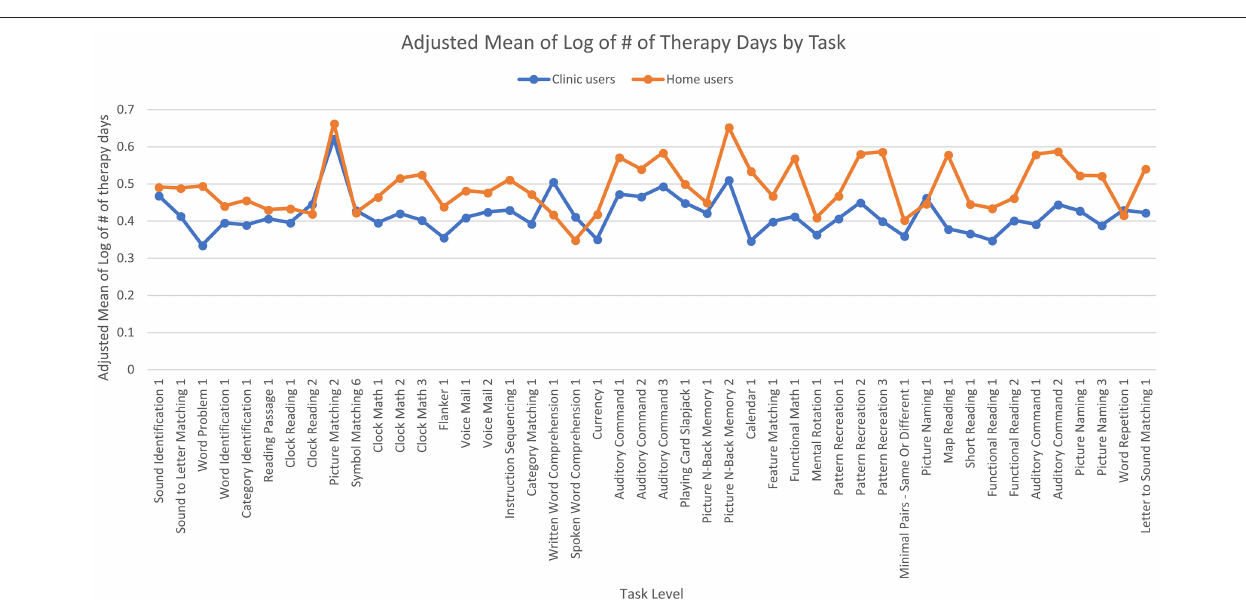
FIGURE 4 | Adjusted means for the number of days of therapy the user completed by user group. Covariates appearing in the model are evaluated at the following values: years since injury = 2.10, age =